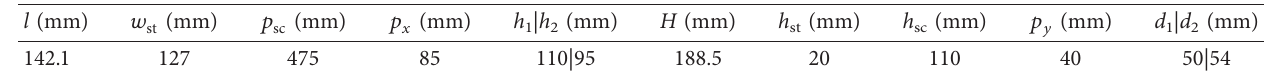
Figure 3: Reflection coefficient curve of different matching structures. a, adaptor without the copper strip and two matching pillars; b, adaptor with metal strip structure only; c, adaptor without multistepped pillar; d, adaptor with complete structure. Table 1: Parameters of matching